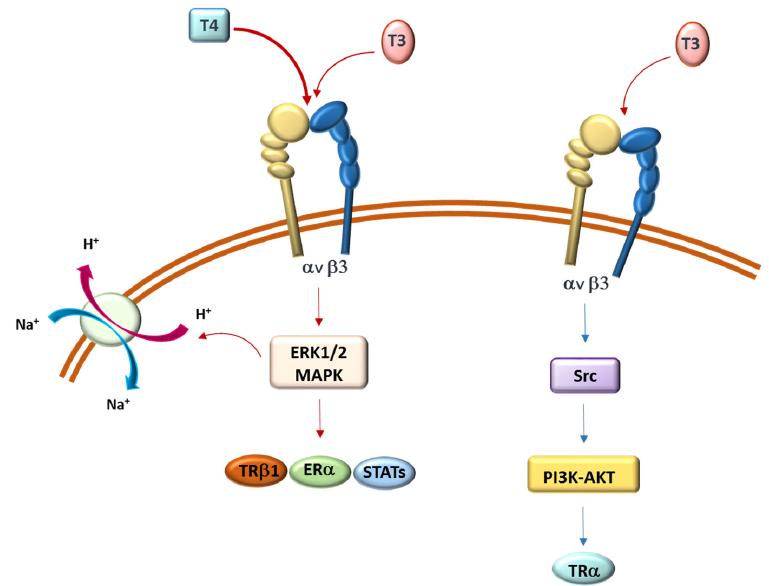
Figure 3. Representation of plasma membrane integrin α v β 3, its interaction with THs (T3 and T4), main cell signaling activated MAPK (ERK1/2) and PI3K–AKT, and main target proteins identified to date (TR β 1, ER α , STATs, Na + /H + antiporter, and TR α 1) [41–45]. At physiological concentrations, T4 is the main ligand for integrin α v β 3 and data obtained with radiolabeled T4 experiments showed that tetraiodothyroacetic acid (tetrac), integrin α v β 3 antibodies, and integrin RGD recognition-site peptide [46] could displace this binding. A study by Cao et al. on CV-1 cells showed that the translocation activity of TR β 1 from the cytoplasm to the nucleus is initiated by T4 at the plasma membrane through the mediation of integrin α v β 3 [42]. In fact, CV-1 cells, which lack nuclear TRs but express plasma membrane integrin α v β 3, once treated with physiological concentrations of T4, show an activation of MAPK pathway which is inhibited by the silencing of integrin α v β 3 [41]. Furthermore, the finding that the occlusion by an antagonist of RGD site of integrin α v β 3 leads to blockage of T4 activity suggests that T4-integrin α v β 3 interaction occurs at or near the RGD site [47]. Molecular modeling studies have demonstrated that the THs and their analogues occupy a much smaller conformational space than does the RGD cyclic peptide (which is the model ligand for RGD binding integrin investigation), suggesting that there can be different possible orientations of THs and analogues in the binding site at the interface between the α v and β 3 domains of integrin α v β 3. For the T4Ac analogue, an interaction with both the subunits is the most probable, with the hydroxylated ring toward α v, while T4 molecule is hypothesized to interact with β 3 subunit. Other small aromatic ligands interacting with α v β 3 integrin (e.g., steroids and resveratrol) can fit into an alternative binding pocket near the RGD binding site, but this site is too small for the THs because of the bulky iodine [48]. Integrin α v β 3 is highly expressed in activated endothelial cells and newborn vessels, as well as some different cancer cell lines and in primary tissue samples from patients [49]; it also correlates with disease prognosis in various cancer types [50–53]. After the first evidence of MAPK pathway activation by TH, TH-mediated cell proliferation and cancer cell growth stimulation was demonstrated in several cell lines. The effect on glioblastoma C6, F98, and GL261 cells was measured by accumulation of proliferating cell nuclear antigen (PCNA) and radiolabeled thymidine incorporation. This effect was inhibited by the T4 analogue, tetrac, and by an integrin α v β 3 RGD recognition-